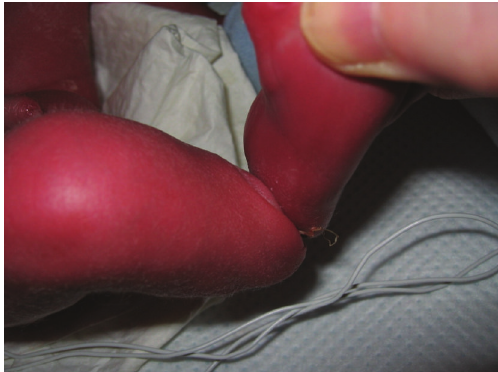
Figure 2: Appearance of the abdomen at 2 years of age before surgery.